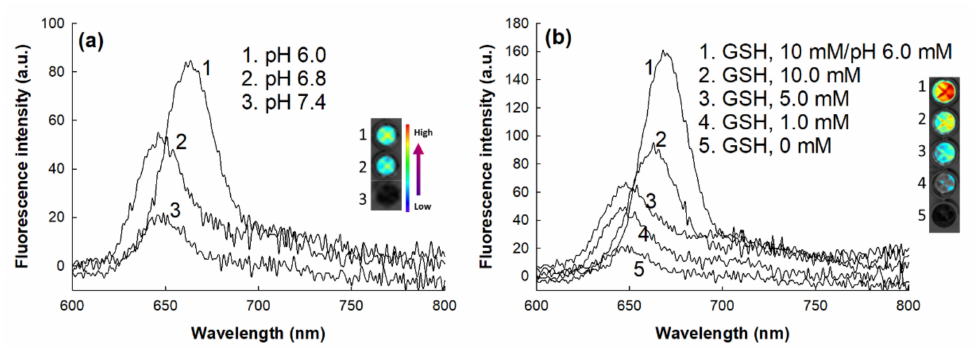
Figure 4. Fluorescence emission spectra of Ce6-loaded ChitoHISss nanoparticles. ( a ) The effect of pH; ( b ) the effect of GSH. Ce6-incorporated ChitoHISss nanoparticles were incubated with various pHs and/or GSH for 4 h. Fluorescence analysis was at least